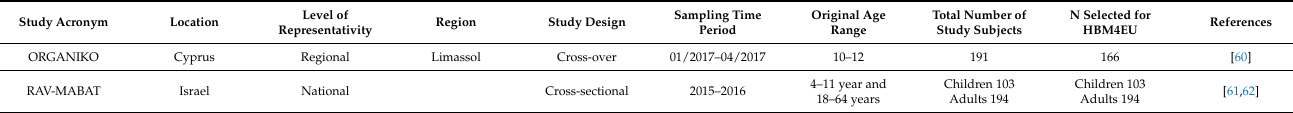
Table 6. Characteristics of ORGANIKO and RAV MABAT